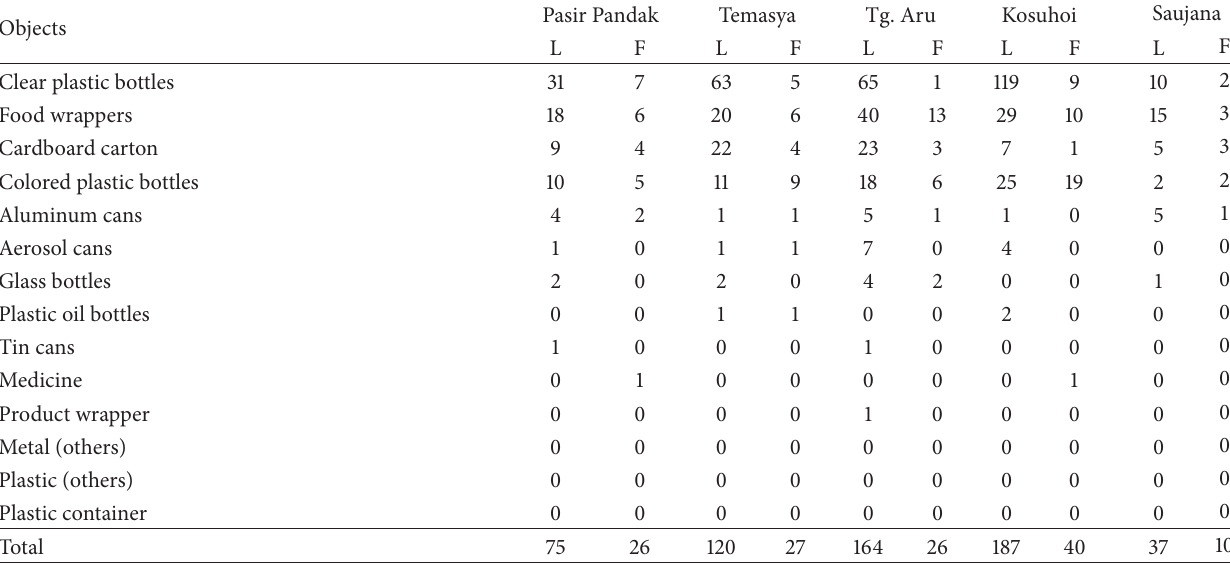
Table 6: Total items for objects (item/km) origin found during beach survey.